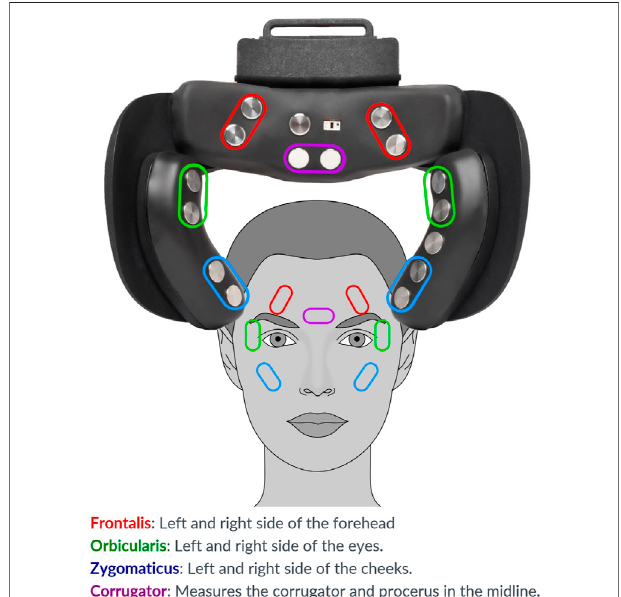
FIGURE 5 | Mapping between emteqPRO sensors and facial